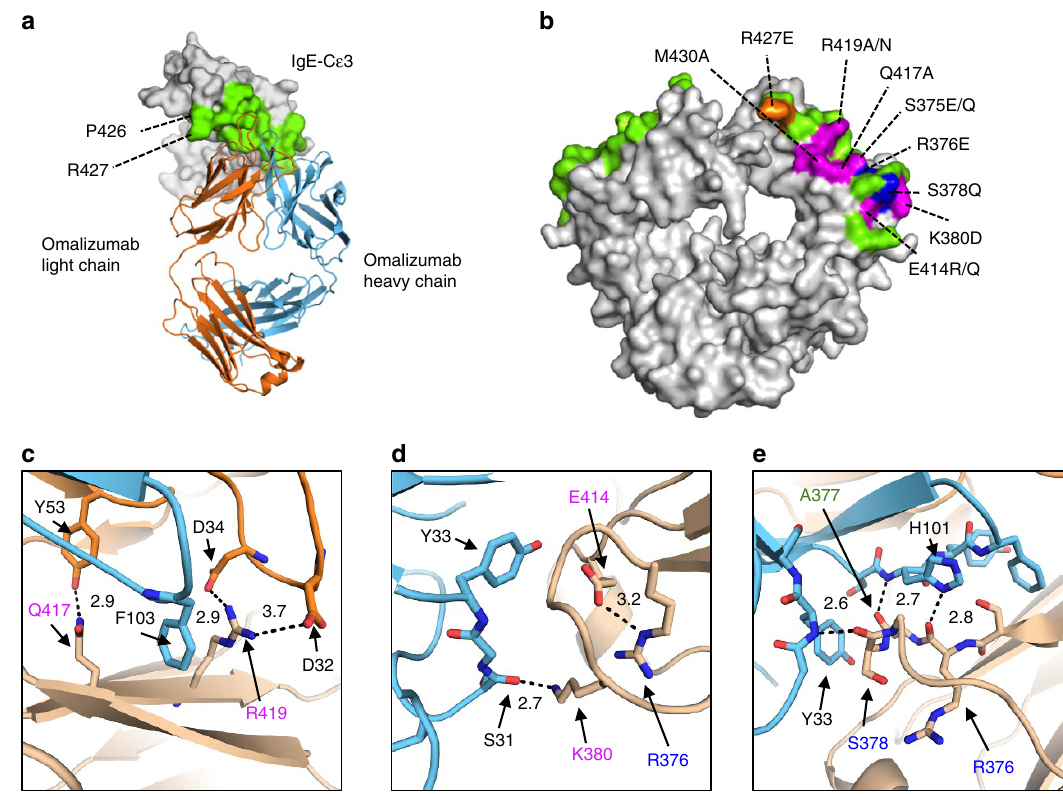
Figure 3 | The omalizumab epitope. ( a ) A top down overview of the omalizumab:IgE complex, with interface residues coloured green and residues shared between omalizumab:IgE and IgE:Fc e RI a complexes labelled. ( b ) Position of previously published IgE heavy chain mutants and a new IgE-Fc 3–4 mutant (R419N) at the omalizumab interface in green. Mutant residues are colour-coded by their relative binding to omalizumab (magenta 0–14%, blue 15–44% and orange 44–75% of wild-type IgE). ( c – e ) Detailed view of the omalizumab:IgE interface, with distances (Å) between atoms predicted to participate in hydrogen bonds or salt bridges shown in black. ( c ) A hydrogen bond between IgE Q417 and omalizumab light chain Y53, and a salt bridge between IgE R419 and light chain D34 and D32. ( d ) A hydrogen bond between IgE K380 and omalizumab heavy chain S31, and an intrachain salt bridge between IgE E414 and IgE R376, two residues implicated in omalizumab:IgE binding studies. ( e ) Hydrogen bonds observed between IgE residues R376, A377, S378 and omalizumab heavy chain residues H101 and sulfate ion (Supplementary Fig. 7). Mutations at R427 (R427E) lead to a minor reduction in omalizumab binding (25–56%), suggesting that this residue can affect omalizumab:IgE inter- actions 24 . In contrast, the R427E mutation substantially reduced Fc e RI a binding to IgE, while another mutant series that contained a R427A mutation only partially reduced Fc e RI a binding 37 . Although omalizumab may directly compete with Fc e RI a for IgE residues, the extent of direct competition and binding site overlap involves at most two amino acids.